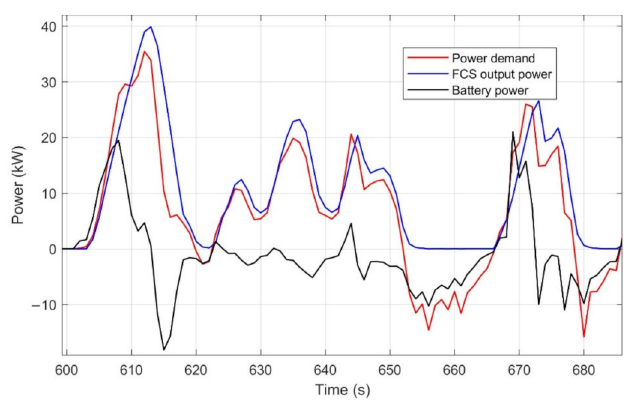
Figure 14. Rule-based power allocation with large load-change condition.